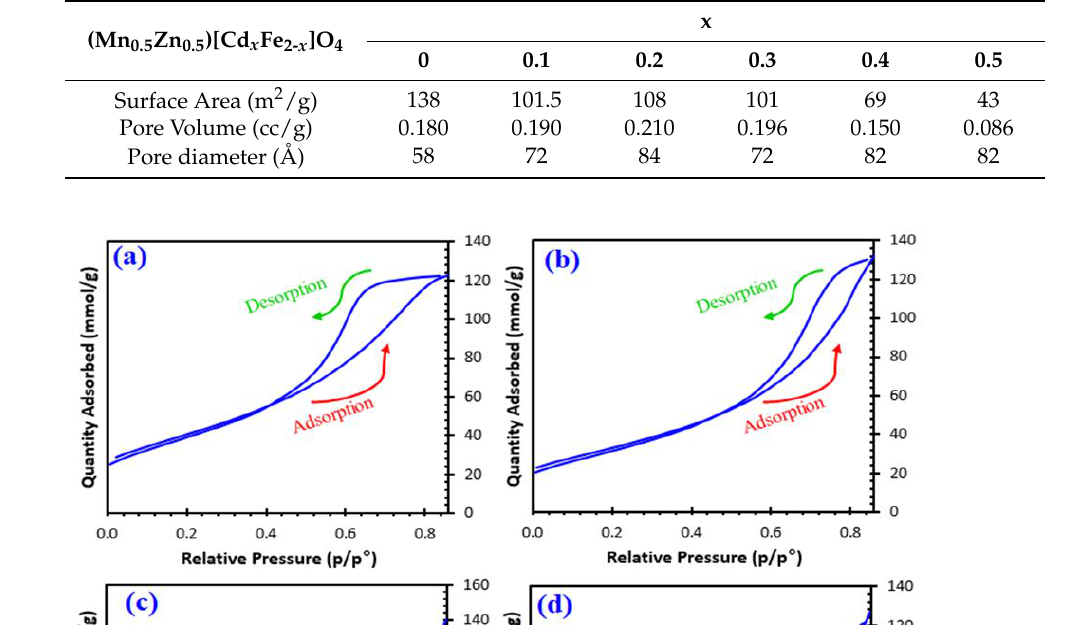
Table 1. Textural properties of (Mn 0.5 Zn 0.5 )[Cd x Fe 2- x ]O 4 (x ≤ 0.05) NSFs.